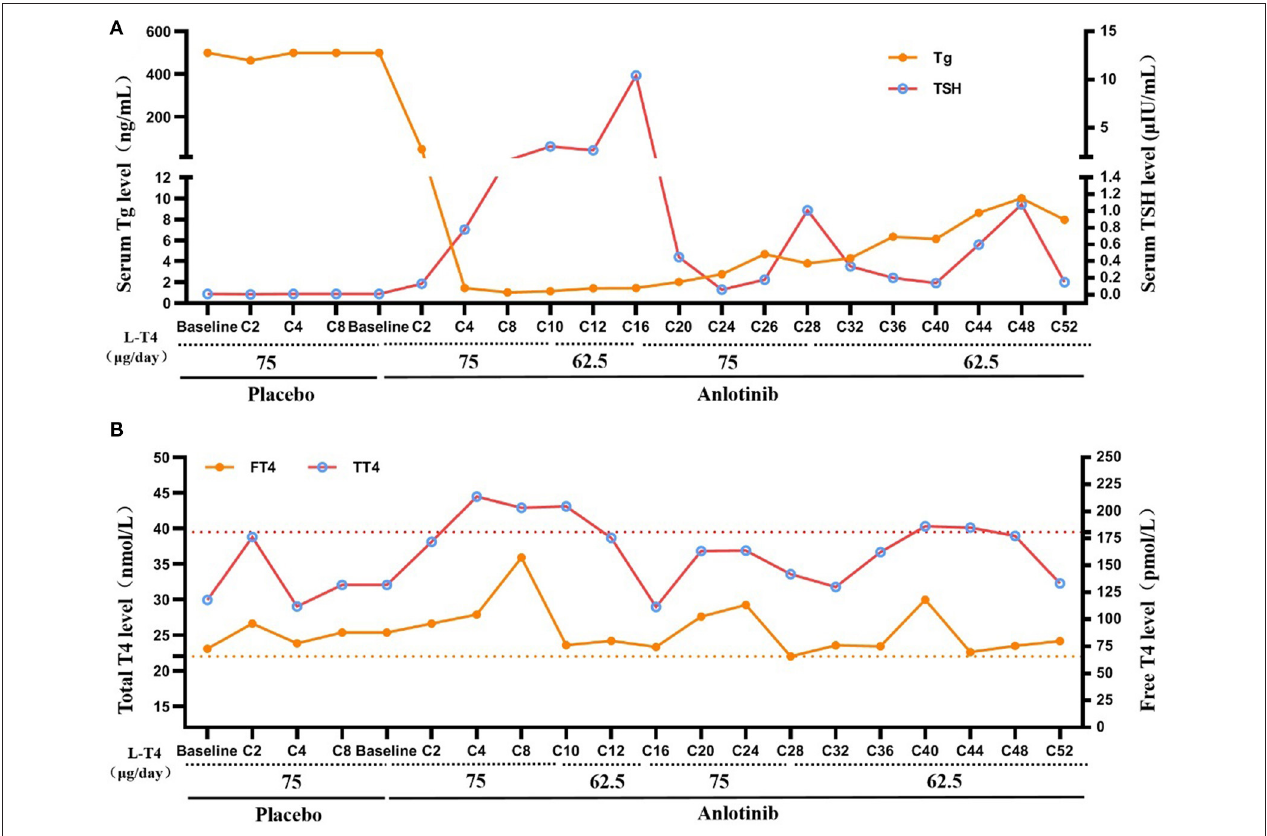
FIGURE 3 | TSH suppression therapy during anlotinib treatment. (A) Change of serum TT4 and FT4 during placebo and anlotinib therapy (Yellow dotted line: upper limit of FT4, Normal range: 12–22 pmol/L; Red dotted line: upper limit of TT4, Normal range: 66–181 nmol/L). (B) Change of serum TSH and Tg during placebo and anlotinib therapy (TSH normal range: 0.27–4.2 µ IU/mL; Tg normal range: